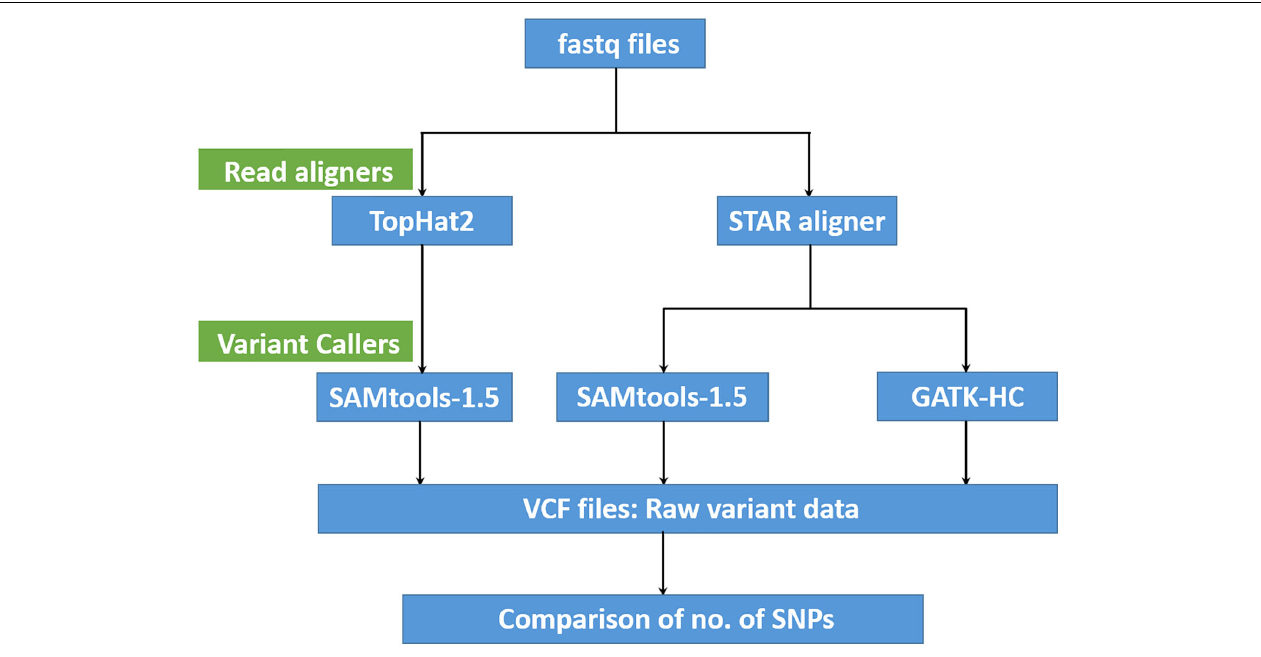
FIGURE 1 | A flow diagram summarizing the performance comparison of variant calling pipelines.